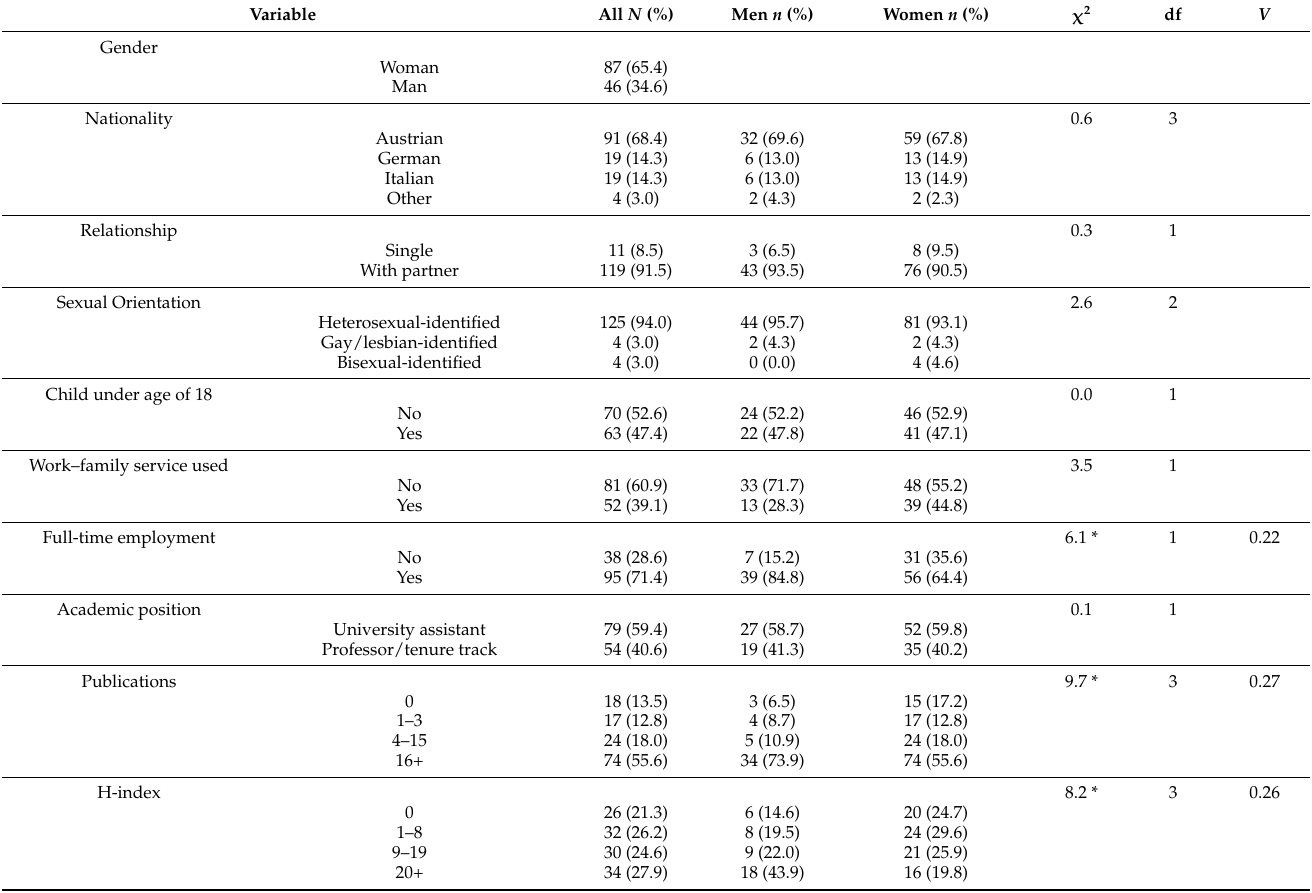
Table 1. Sociodemographic description of the